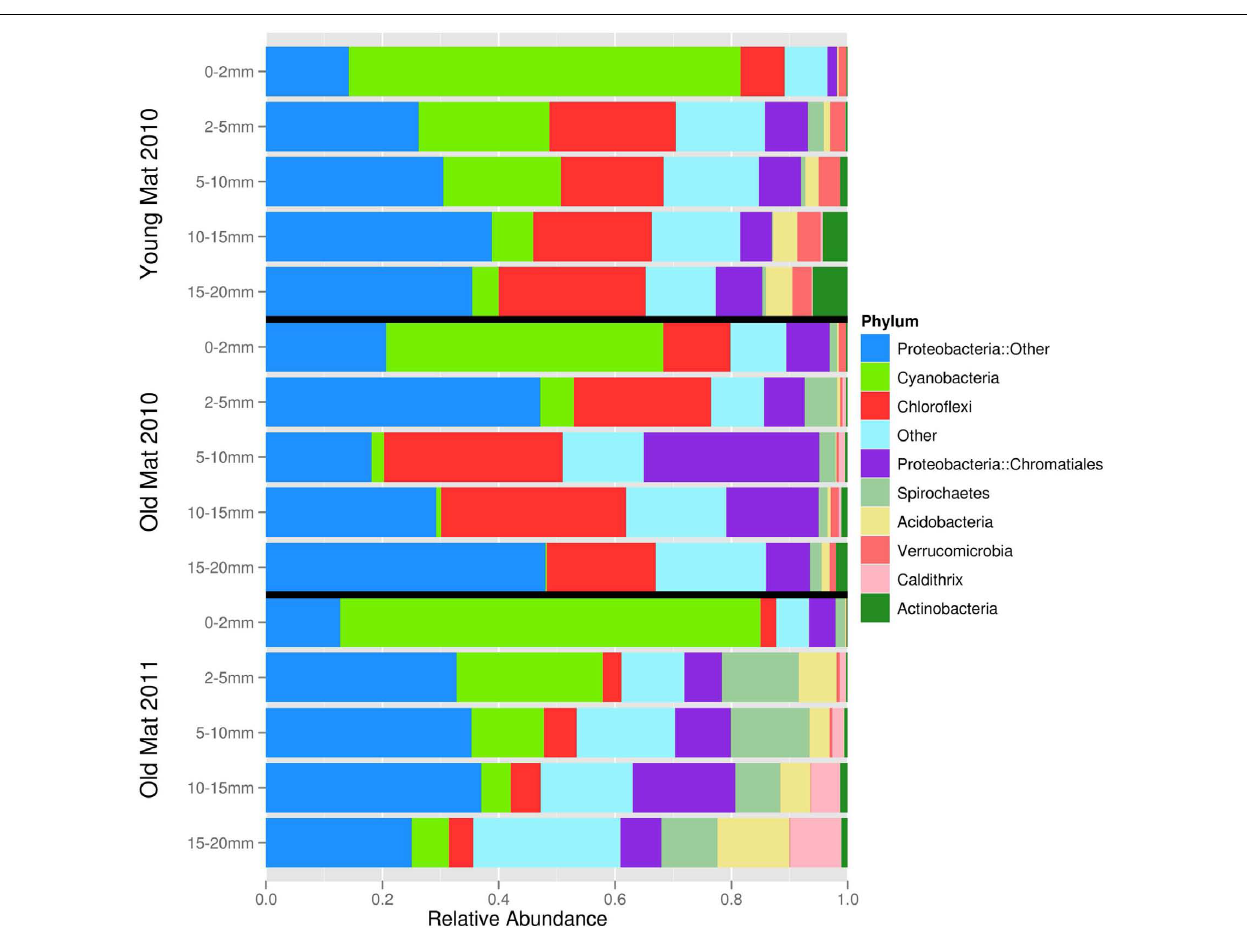
Bacteroidetes, Chlamydiae, Chlorobi, Firmicutes, Fusobacteria, Gemmatimonadetes, Lentosphaerae, Nitrospirae, Planctomycetes, Tenericutes,Thermi, and candidate divisions ABY1, BRC1, GN02, GN04, GN06, GN12, HYD24-12, KSB1, LCP89, MSBL6, MVP-15, NKB19, OP8, OP9, OP11, SAR406, SC4,TG3,TM6,TM7,WPS-2,WS1,WS3,